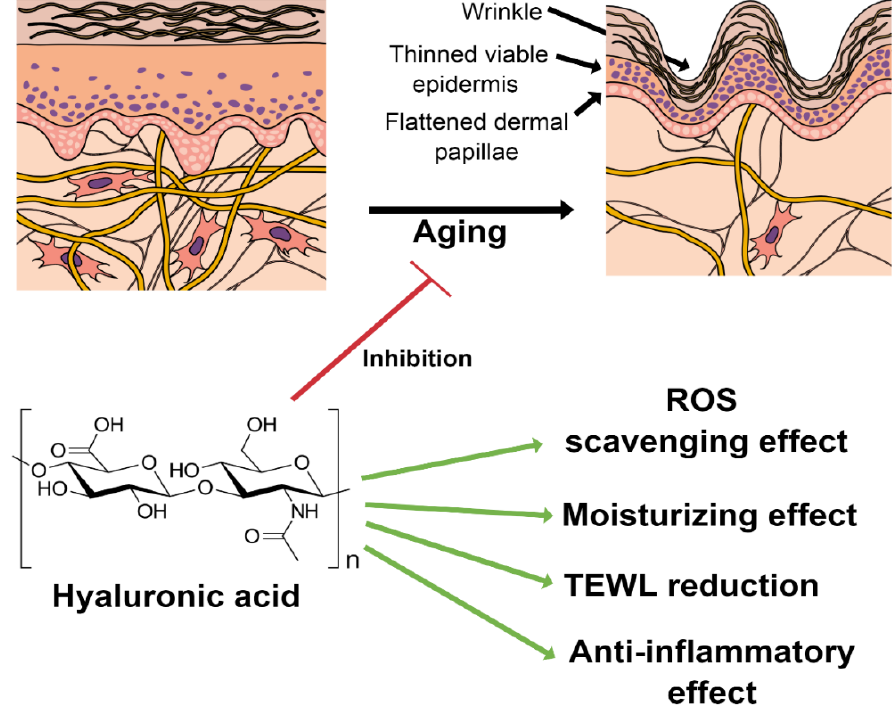
Figure 5. The results obtained after regular use of products containing HA, which demonstrated its role as an active ingredient [81–84].